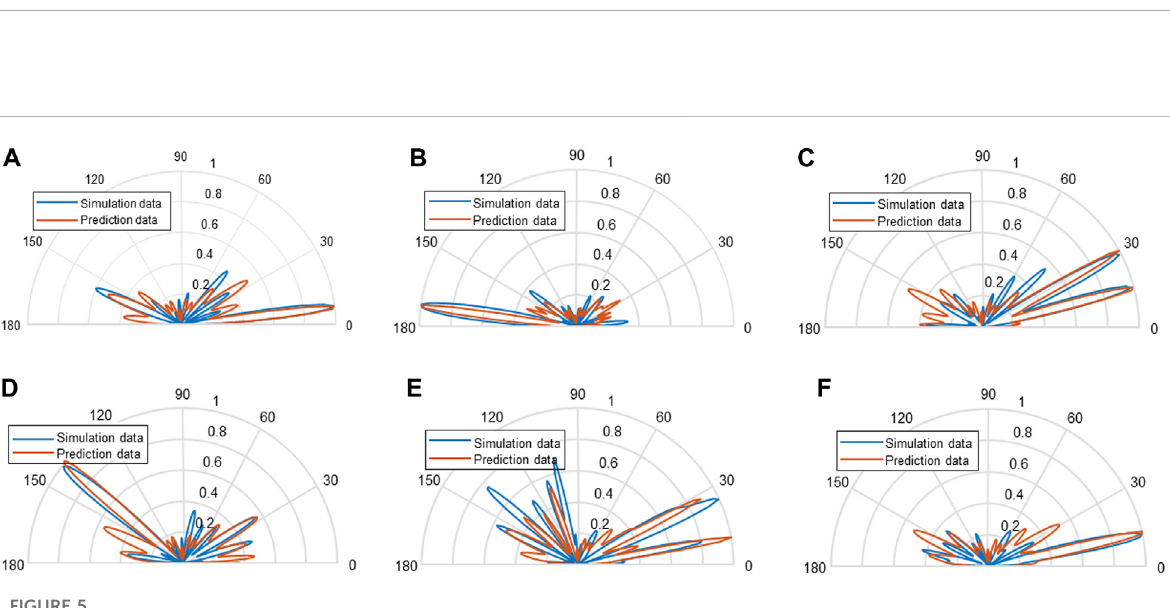
FIGURE 4 Training results. (A) The loss function decreases with the increase of training epochs. (B) With the increase in training times, the accuracy rate increased and tended to be stable when the epoch was about 1100.